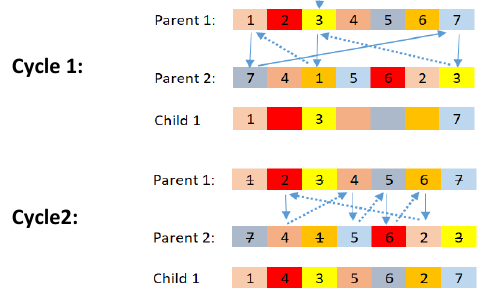
Fig 2. The Process of Cycle Crossover